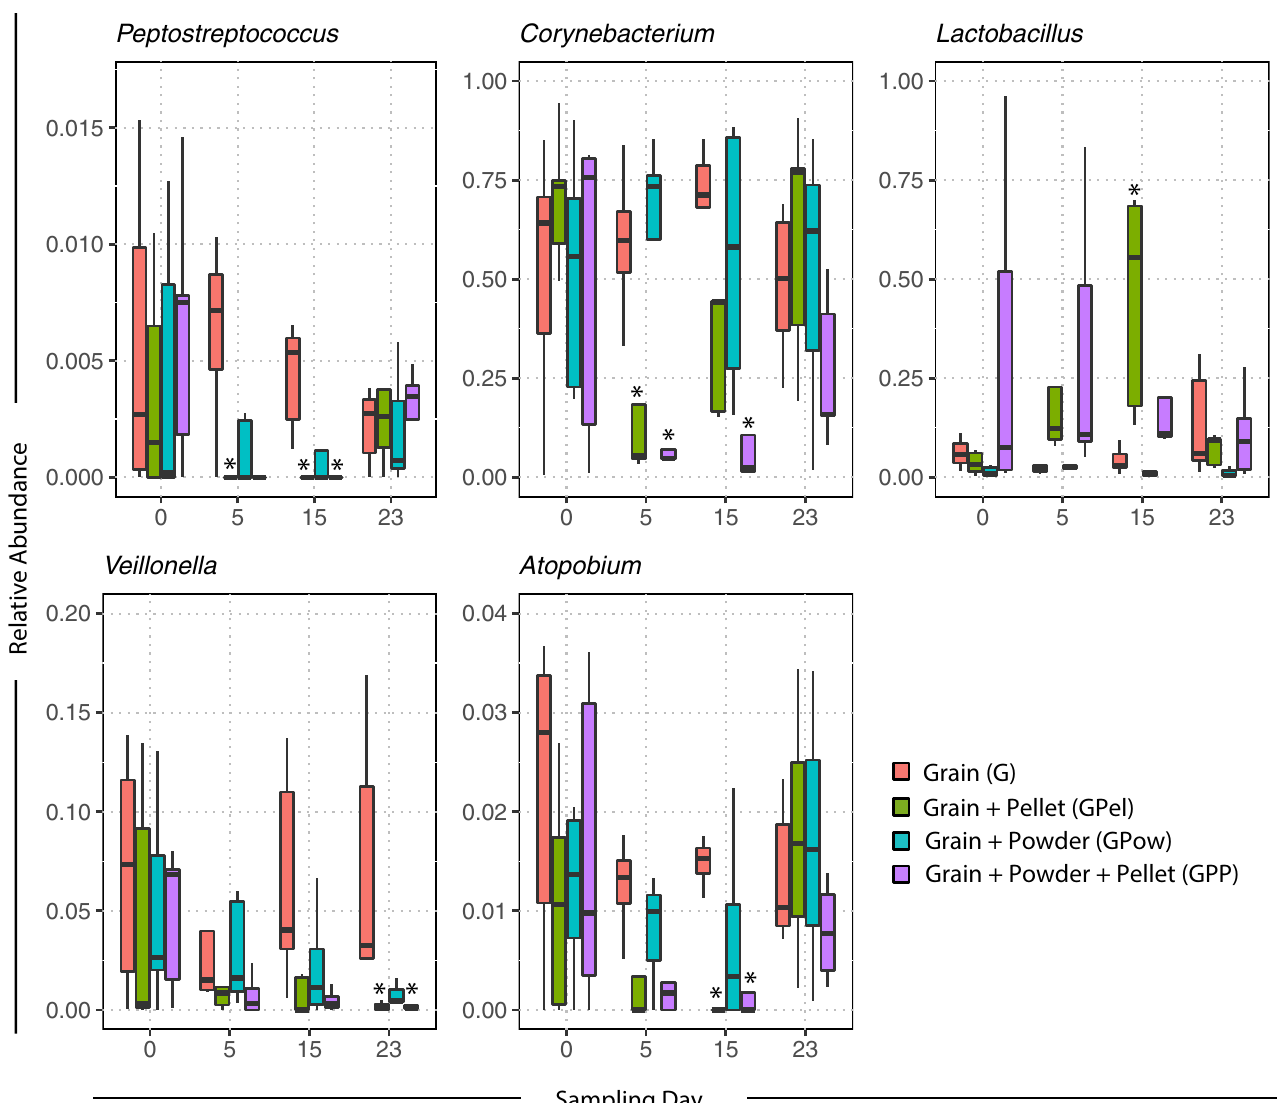
Fig 3. Relative abundance of bacterial genera before (day 0), during (day 5) and after treatment (day 15 & 23) with probiotic pellets and powder. Asterisks ( � ) indicate significant ( α = 0.05) differences from the Grain (G) control treatment.